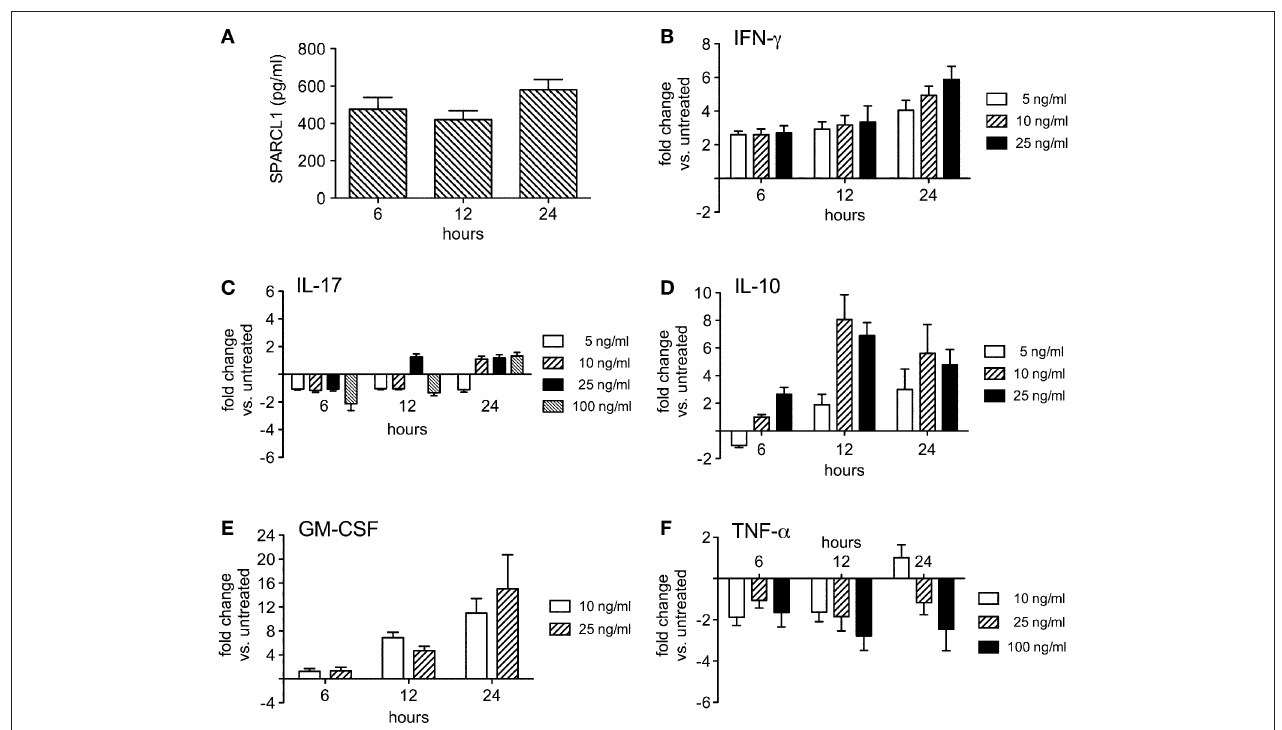
FIGURE 6 | T cell-derived cytokines regulate astrocyte production of SPARCL1 in a complex manner in vitro. (A) Astrocytes spontaneously secrete measurable amounts of SPARCL1 into culture supernatants ( n = 4 experimental replicates per time point). (B) Interferon-gamma (IFN- γ ) modestly increases astrocyte SPARCL1 release ( n = 3 experimental replicates per time point), p = 0.003 comparing changes over time. (C) Interleukin (IL)-17 has no significant effect on astrocyte SPARCL1 production ( n = 3 experimental replicates per time point). (D) IL-10 potently induces astrocyte SPARCL1 production ( n = 3 experimental replicates per time point), p = 0.0003 comparing changes over time, p = 0.002 comparing fold change differences. (E) Granulocyte macrophage colony stimulating factor (GM-CSF) potently induces astrocyte SPARCL1 production ( n = 3 experimental replicates per time point), p = 0.0024 comparing changes over time. (F) Tumor necrosis factor (TNF)- α suppresses astrocyte SPARCL1 production ( n = 3 experimental replicates per time point), p = 0.0384 comparing fold change